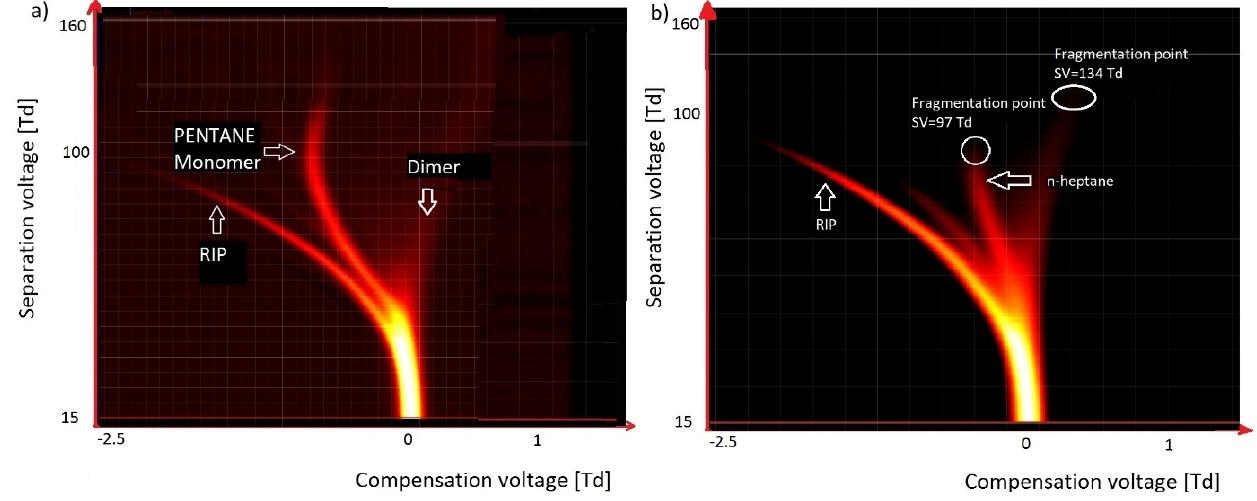
Figure 5. Dispersion plots for ( a ) pentane and ( b ) heptane. In the case of n-pentane, we observed a stable monomer ion with a high amplitude and a dimer. For n-heptane, we observed a monomer that was fragmented in a reduced electric field of 97 Td. For pentane, the fragmentation point was at a much higher value of 138